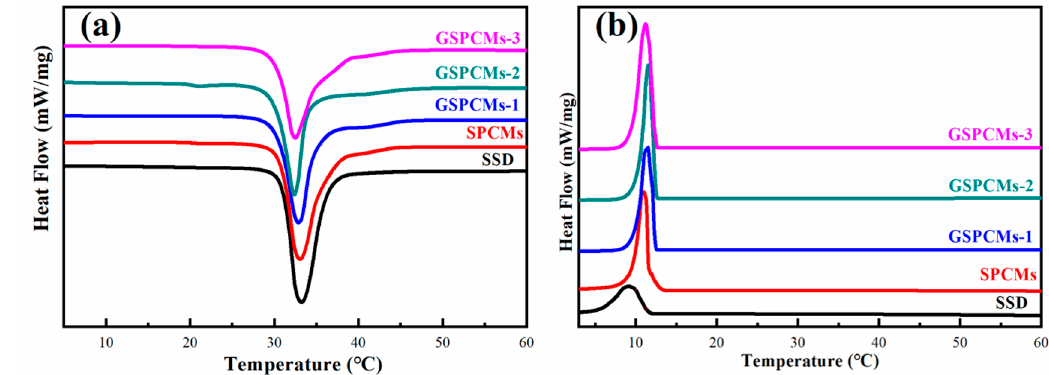
Figure 6. Differential scanning calorimeter (DSC) curves of Na 2 SO 4 ·10H 2 O, S-PCMs and GS-PCMs. ( a ) melting process, ( b ) cooling process. Table 2. Phase change performances of the pure Na 2 SO 4 ·10H 2 O and composite PCMs.